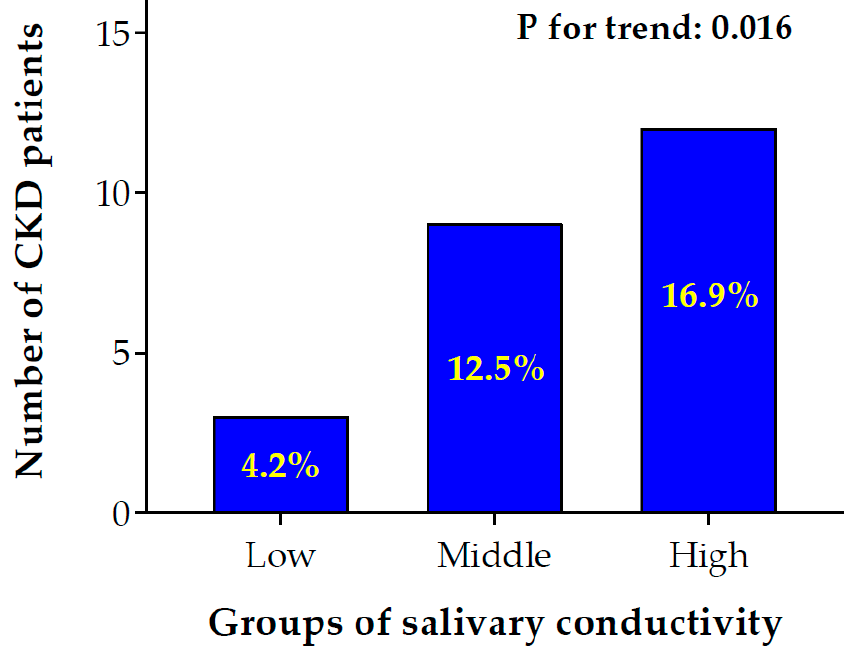
Figure 5. Bar chart of the number of CKD patients with low to high salivary conductivity levels. Participants were separated into low, middle, and high salivary conductivity levels based on the tertials of conductivity levels (low ≤ 4.84 ms/cm; 4.84 ms/cm < middle ≤ 6.60 ms/cm; high > 6.60 ms/cm). The number and percentage of patients with CKD were shown in the bar chart ( p for trend: 0.016). CKD, chronic kidney disease.